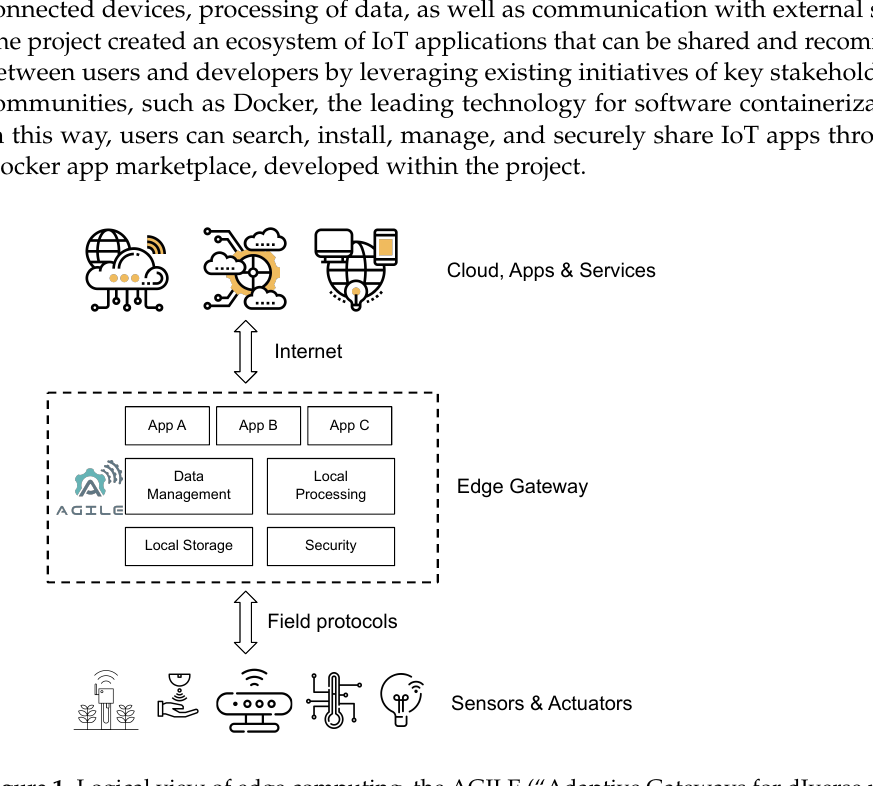
Figure 1. Logical view of edge computing, the AGILE (“Adaptive Gateways for dIverse muLtiple Environments”) gateway, and its main